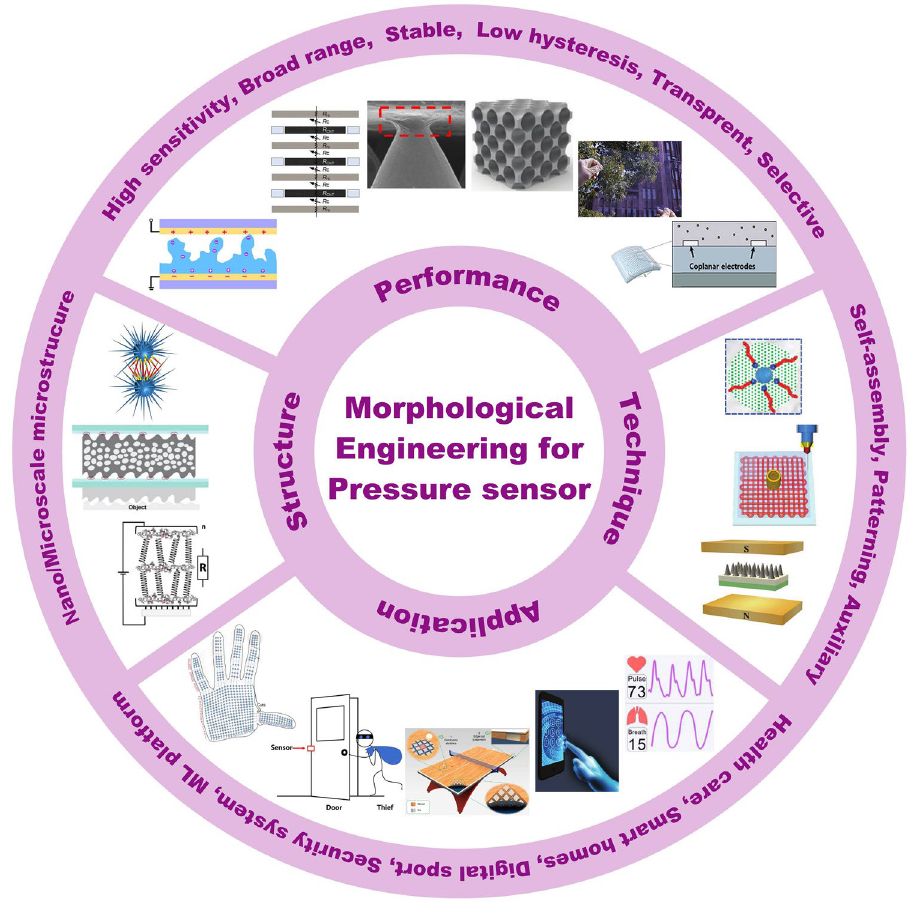
Fig. 1 Summarization of structure, performance, technique and application for flexible micromorphological pressure sensor. Sensing materials with variable nanometer-scale microstructure [96]. Copyright (2018) Wiley–VCH, micrometer-scale microstructures [74, 108]. Copyright